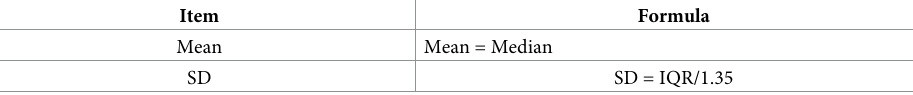
Table 1. Formula for converting median and interquartile range (IQR) into mean and standard deviation